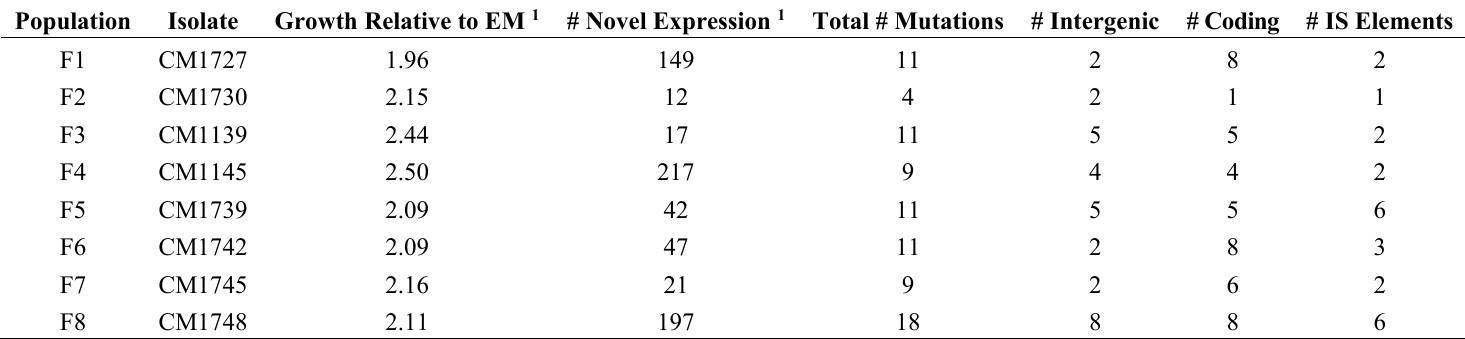
Table 1. Summary of F population isolates at G600.